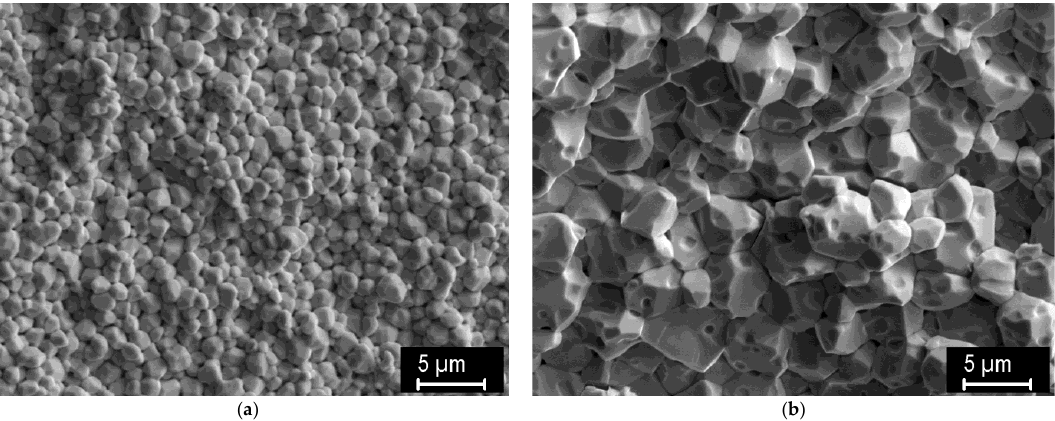
Figure 4. Fracture surfaces of samples sintered from the 0.4 μ m powder; ( a ) at 1400 °C, ( b ) 1700 °C.